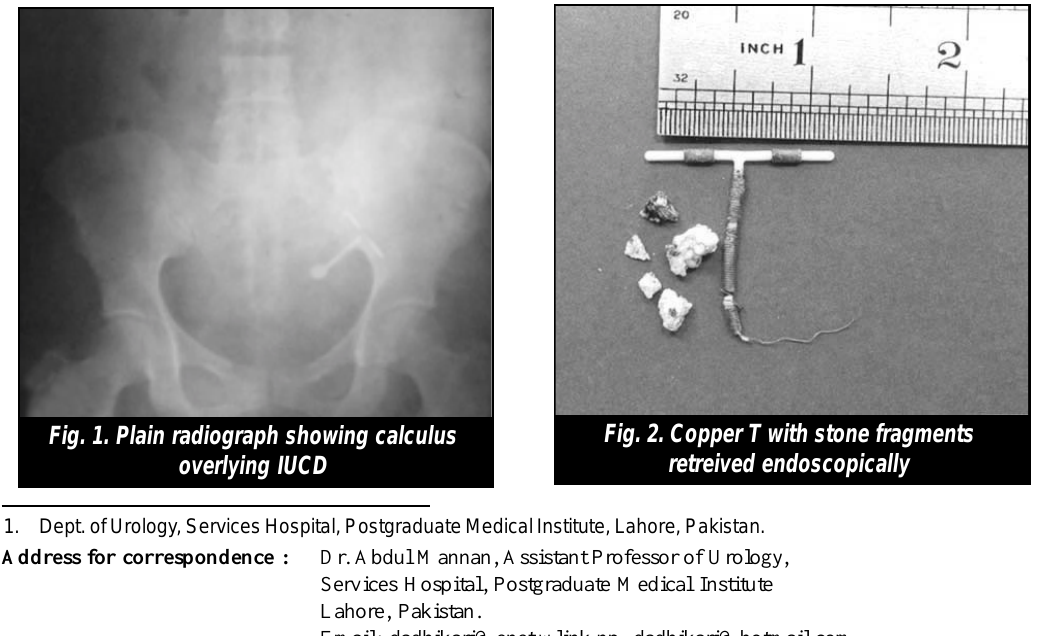
Fig. 1. Plain radiograph showing calculus overlying IUCD